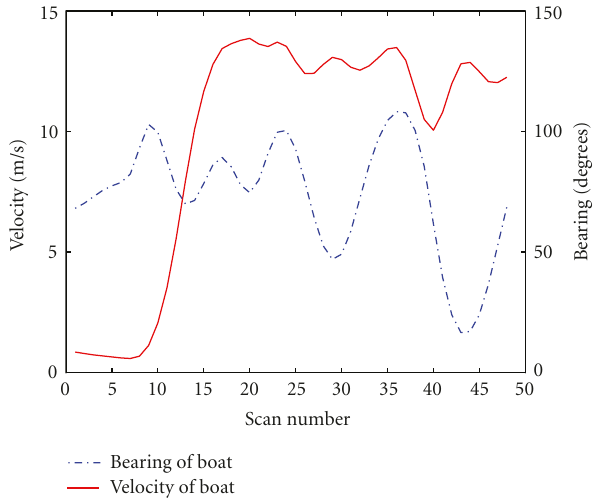
Figure 4: Velocity and bearing of boat for each scan during trial collection period.